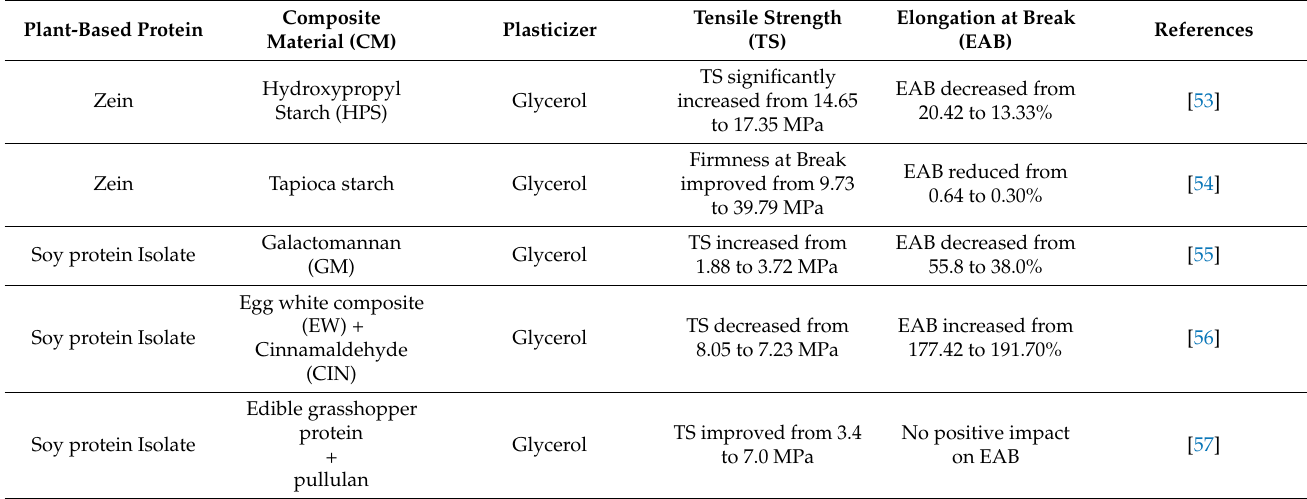
Table 2. Mechanical properties of composite films containing plant